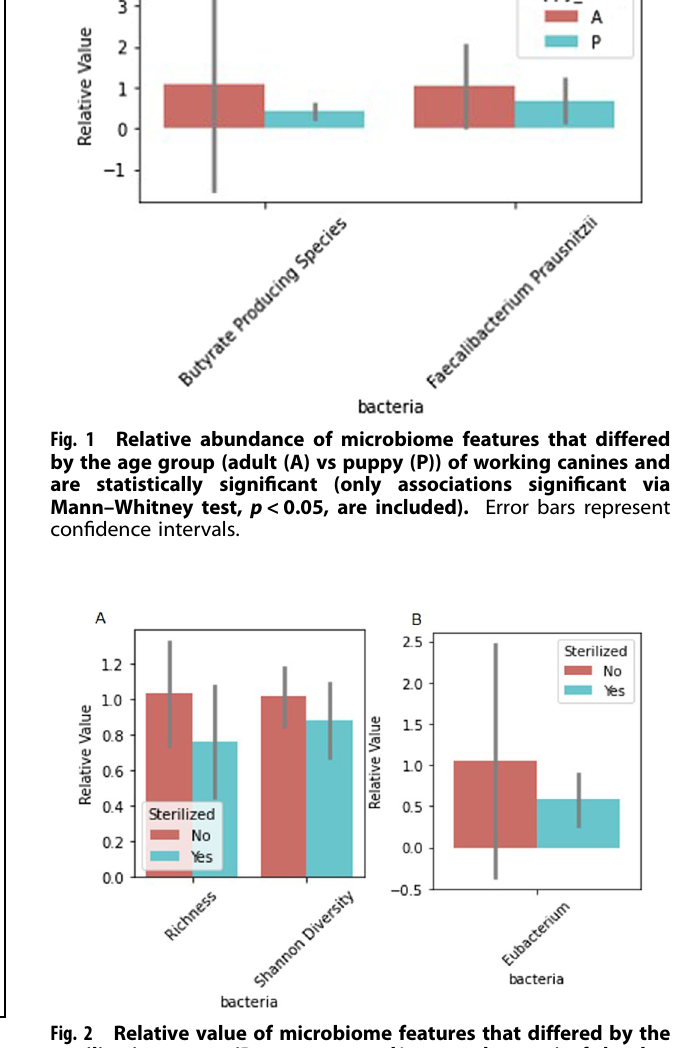
Table 1. Demographics of sampled working canines (Total n = 134).